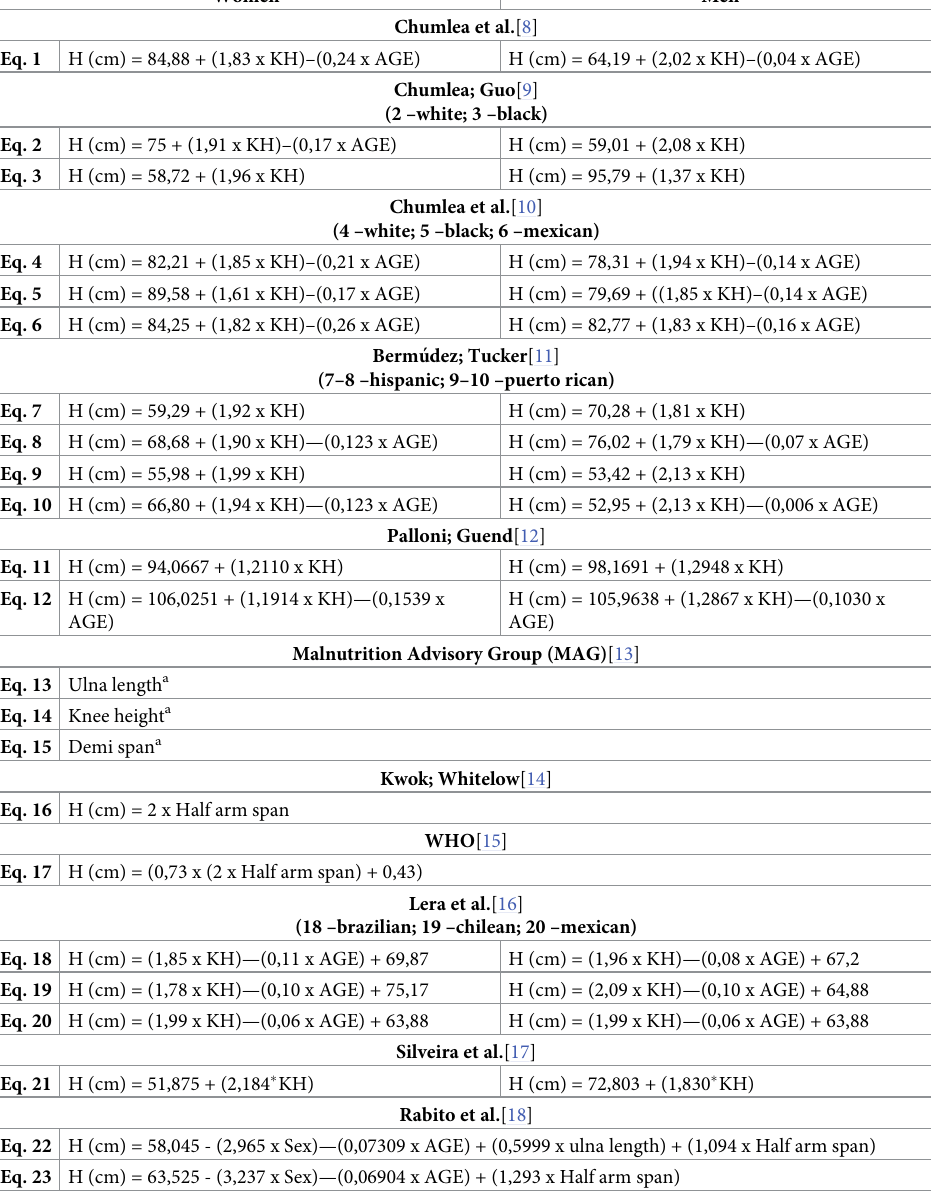
a : standardized table available in < https://www.bapen.org.uk/pdfs/must/must_explan.pdf >